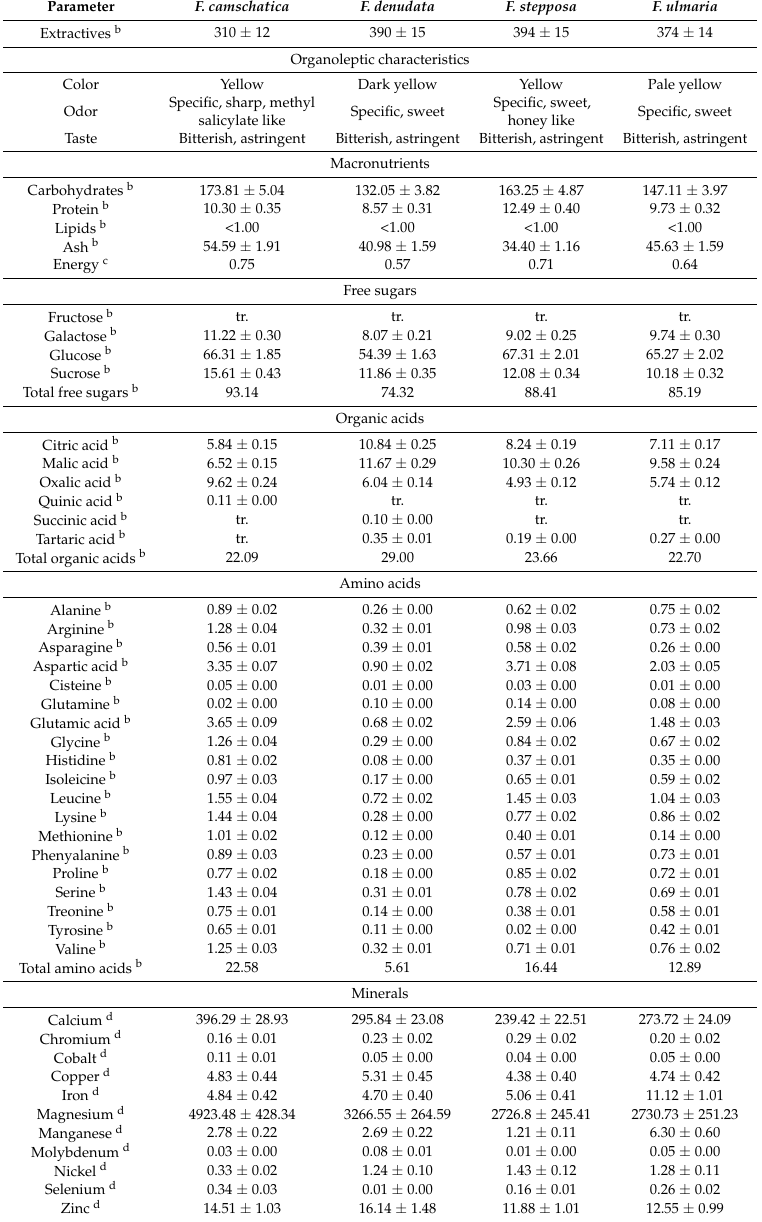
Table 1. Organoleptic, macronutrients characteristics, free sugars, organic acids, amino acids and minerals composition of four meadowsweet teas (mean ± SD) a